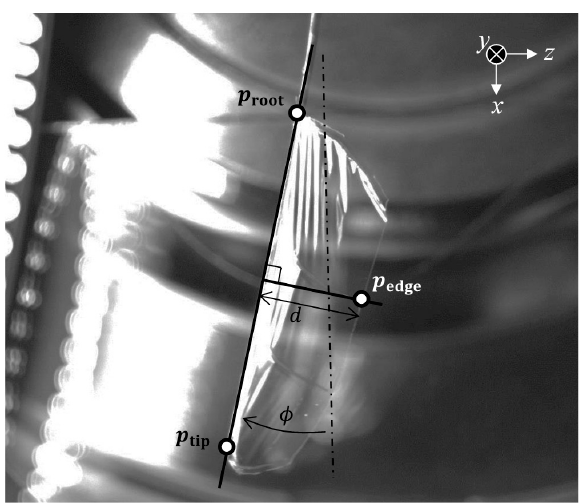
Figure 7. Stroke and pitching measurement from captured image.